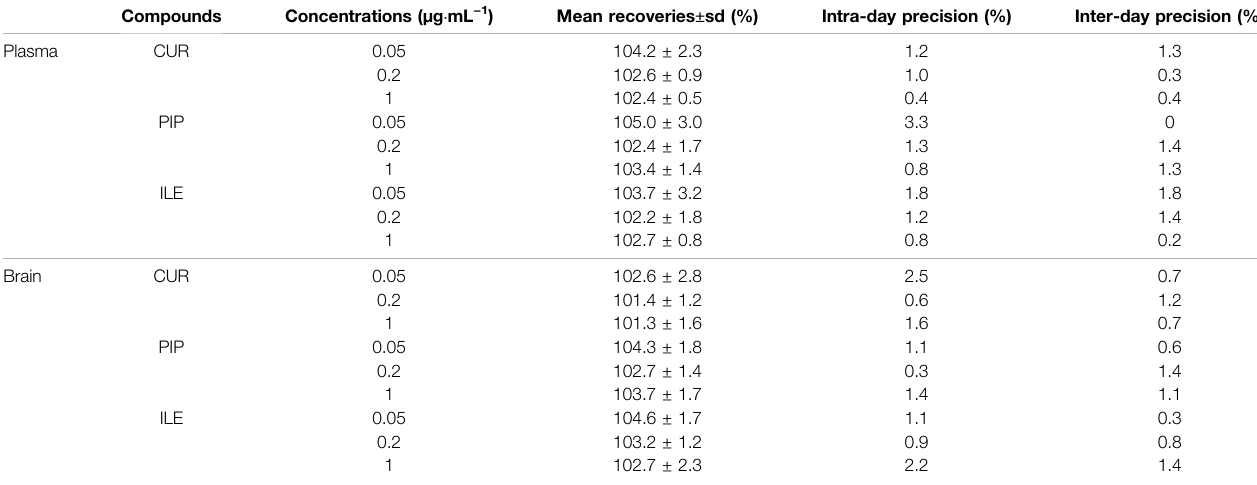
TABLE 3 | Intra-day precision and Inter-day precision of plasma and brain. Compounds